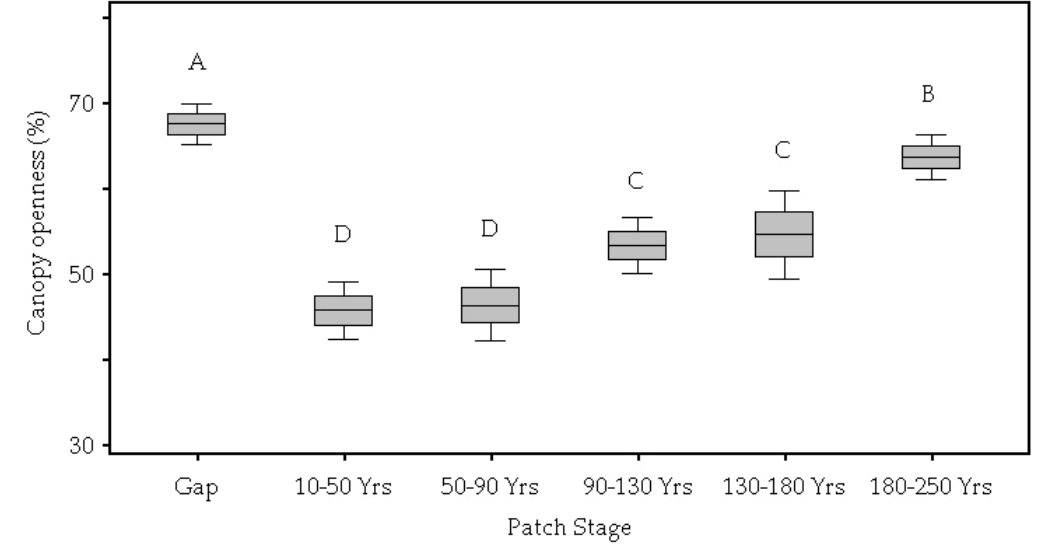
Figure 3. Total canopy openness in patch stages. Canopy openness (%) of plots in each patch stage ( n = 10). Boxes represent plot distribution within one standard deviation of the mean (box centerline). Error bars indicate standard error and shared letters indicate non-significant differences among patch stages.